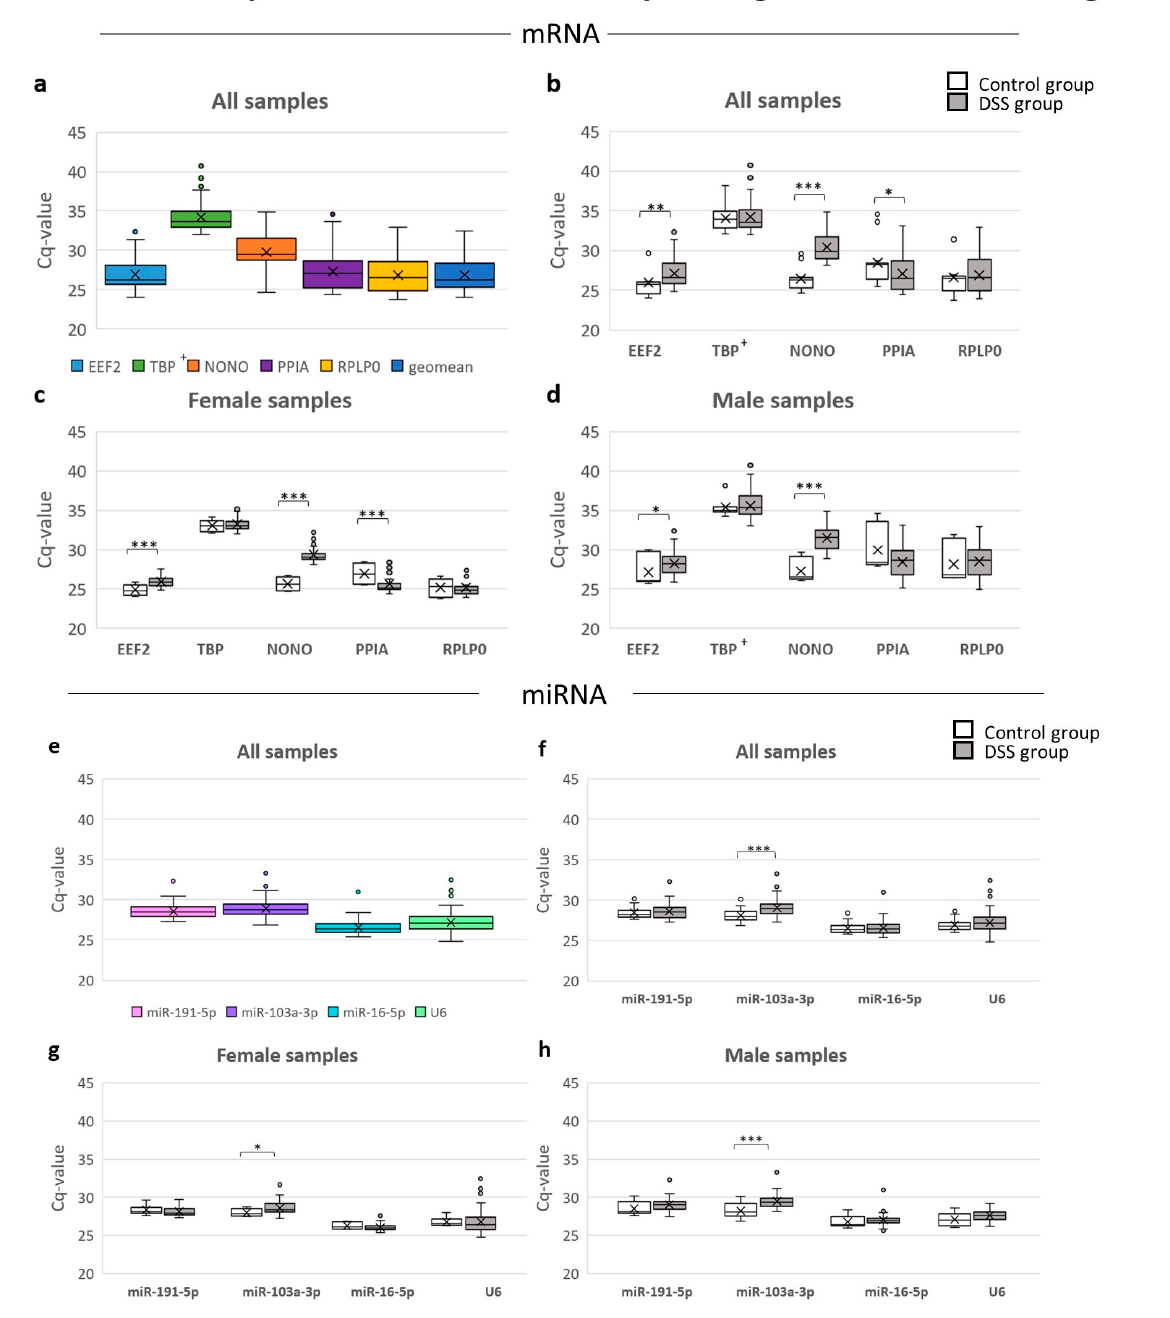
Figure 2. Expression levels and stability of candidate reference genes in archived FFPE colon samples of control and DSS-treated C57BL6/JOlaHsd mice (n = 117). ( a ) mRNA candidate reference genes in FFPE samples regardless of sex or DSS treatment, ( b ) in regard to DSS treatment, and ( c , d ) sex. ( e ) miRNA candidate reference genes in FFPE samples regardless of sex or DSS treatment, ( f ) in regard to DSS treatment, and ( g , h ) sex. Archived FFPE colon samples were selected from 9 DSS experiments conducted during a 4-year period (2010-2014) and were composed of control (n = 20; 10 female, 10 males) and DSS group (n = 97; 47 females, 50 males). Legend: the box indicates the 25th to 75th percentiles; x denotes the mean; the error bars denote the maximum and minimum value; statistical significance: * p ≤ 0.05, ** p ≤ 0.01, *** p ≤ 0.001; TBP†, 16 of 117 FFPE samples were undetermined for TBP, 2 from the control and 14 from the DSS group, all undetermined FFPE samples were males.